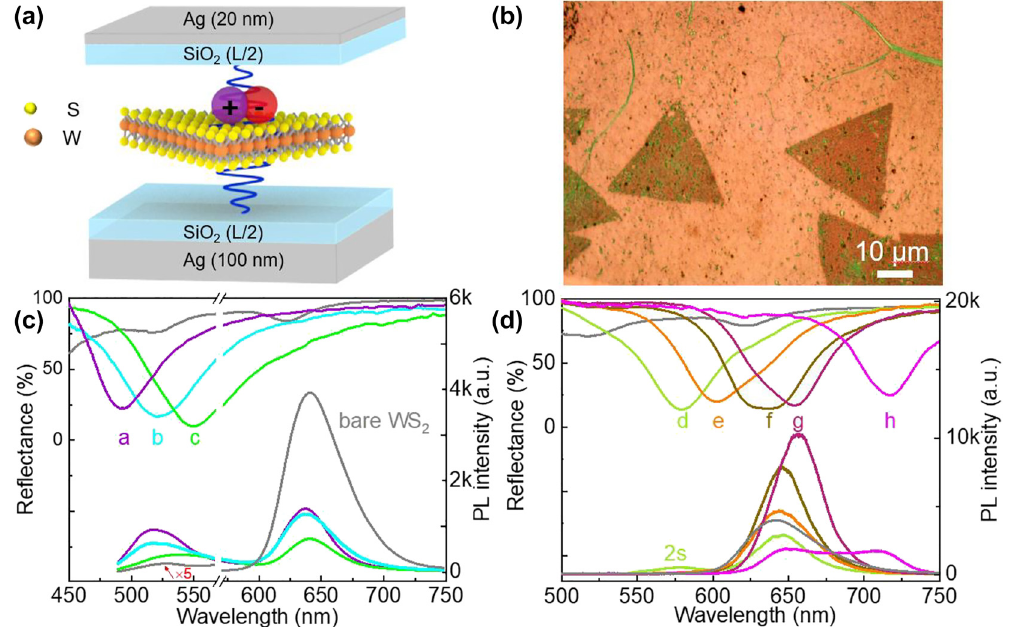
Figure 1: Modulation of the WS device. (c) and (d) the reflection and PL spectra of WS